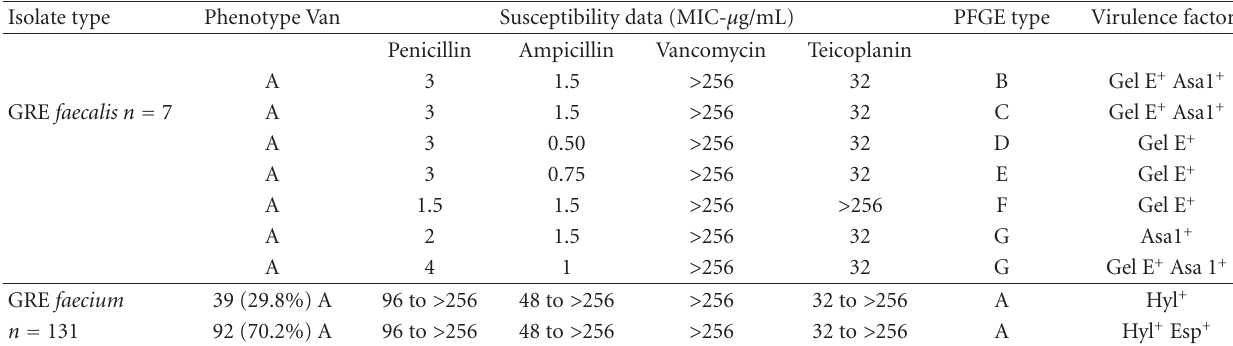
Table 5: Characteristics of glycopeptide-resistant isolates.